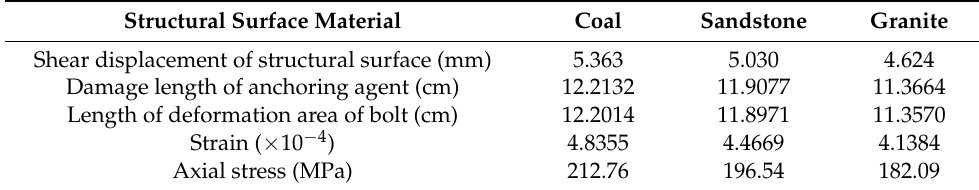
Table 4. Parameters of local deformation region of bolt